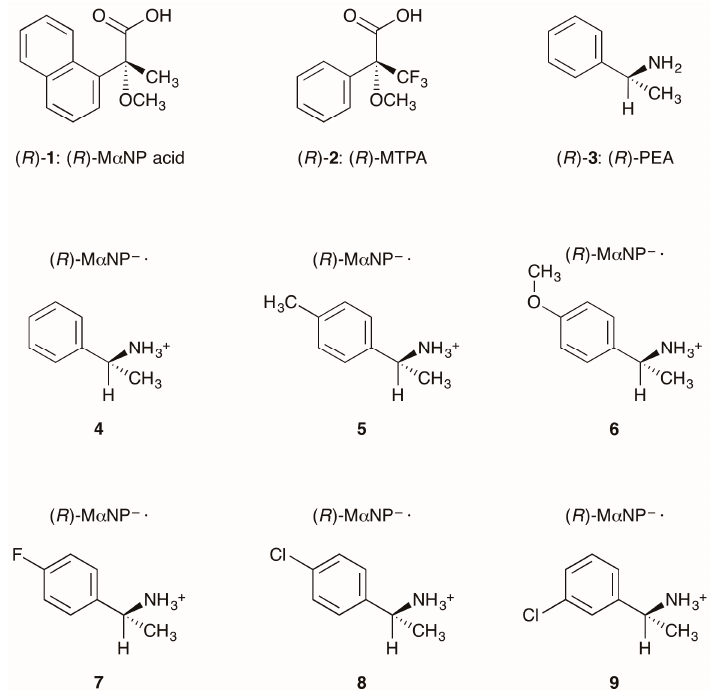
Figure 1. Structures of chiral resolving agents and M α NP salts. See refs. 6 and 11 for salt 4 (CCDC 801461) and salt 5 (CCDC 871216), respectively. ( R )-M α NP – represents the ( R )-2-methoxy-2-(1-naphthyl)propanoate anion.